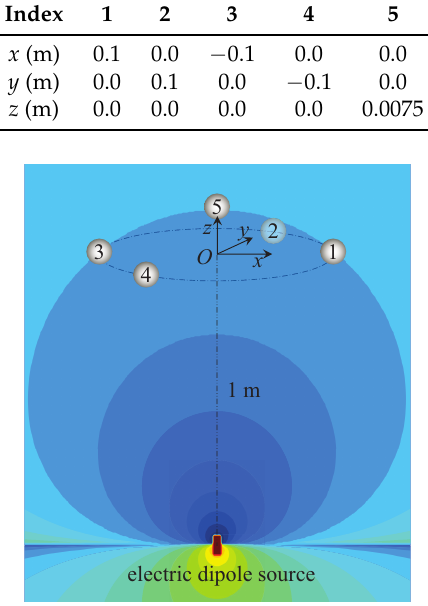
Figure 2. The improved UCA system with the electrodes being settled at the equipotential